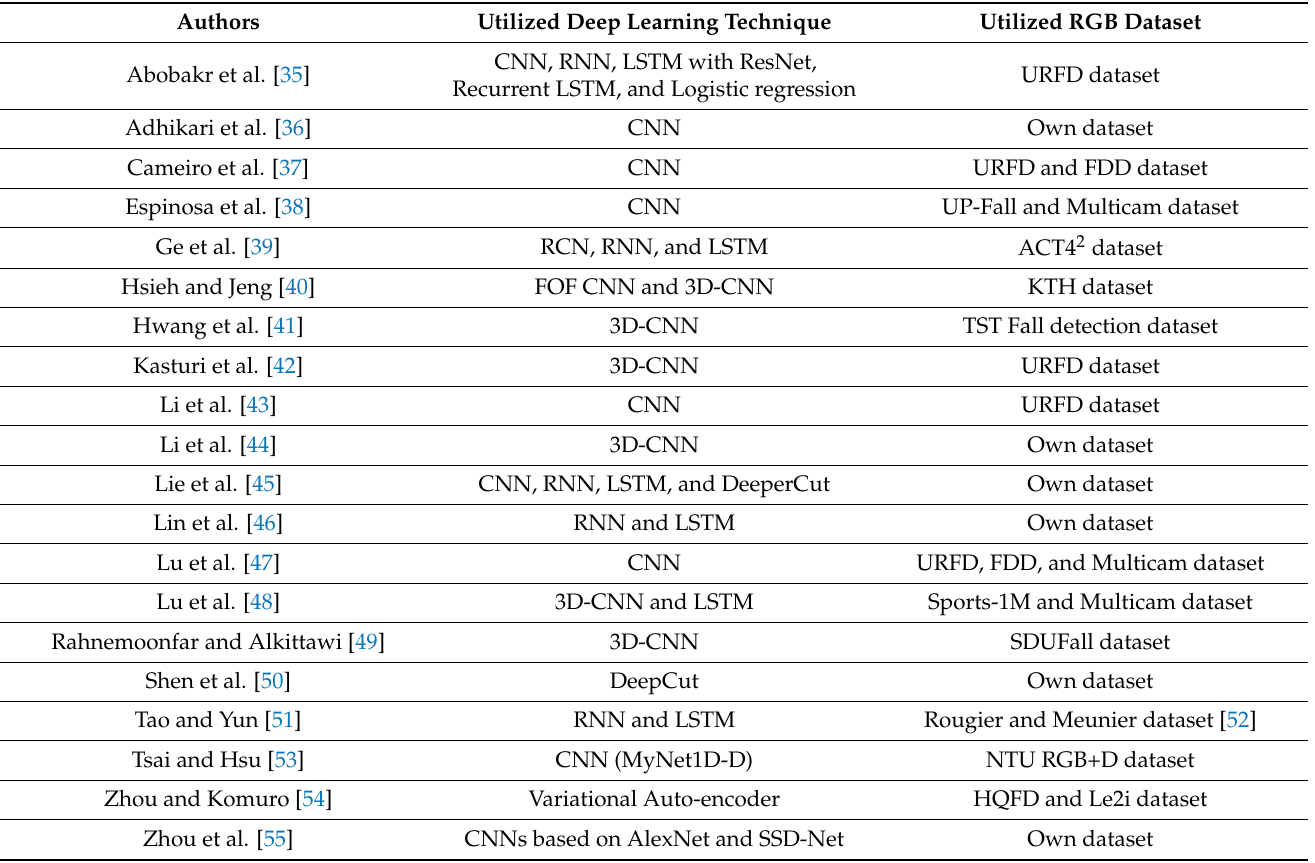
Table 1. Summary of the state-of-the-art machine learning techniques employed for human fall